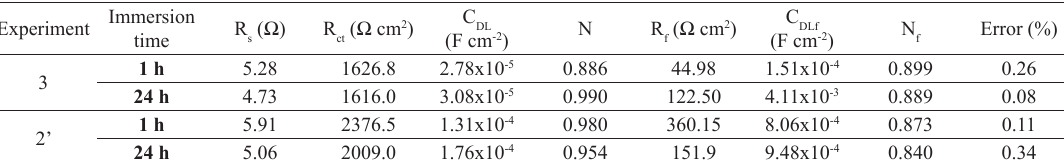
Table 8 - Simulated results obtained from the EIS data obtained for the coating/substrate systems, produced under the conditions of Experiments 3 and 2’(DC and PC produced systems, respectively), after 1 h and 24 h of exposure to the corrosive medium and using the equivalent circuits presented in Figure 7B.